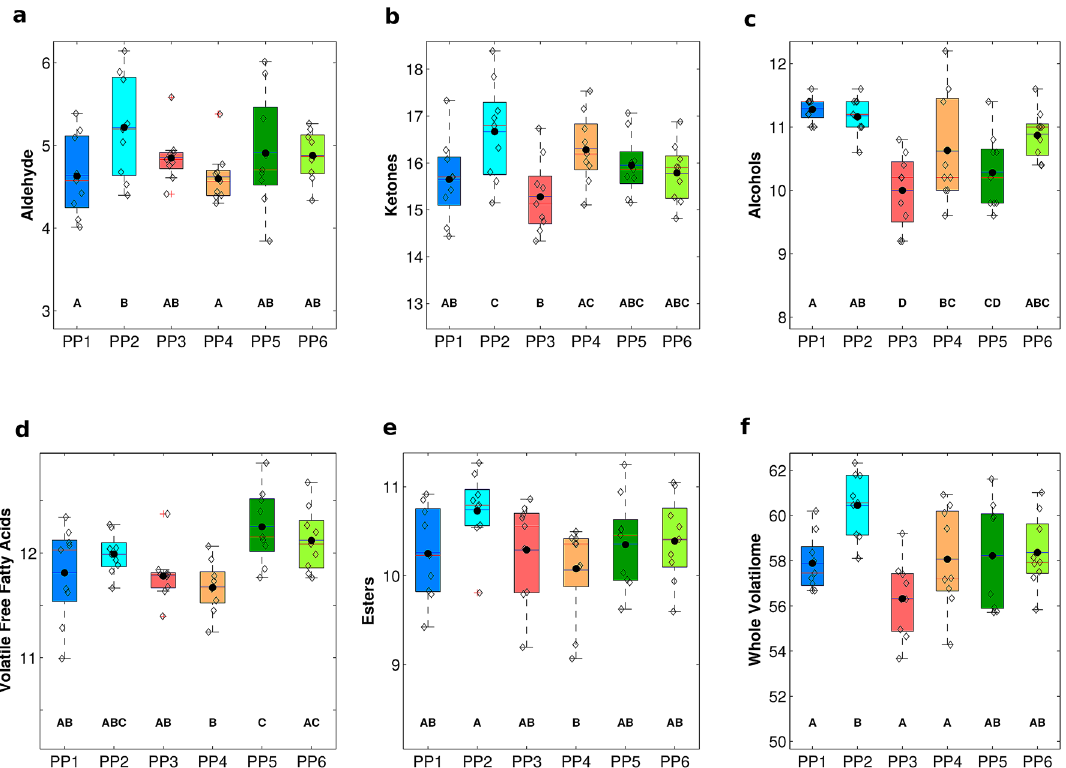
Figure 5. Box-plot of contents of the volatile compounds for each Pasture area-Producer: ( a ) aldehyde, ( b ) ketones, ( c ) alcohols, ( d ) volatile free fatty acids, ( e ) esters, ( f ) whole volatilome. Rhombus refer to HR cheese replicates. A mean value relative to cheese samples collected is indicated for comparison (dotted line). Data expressed as log 10 of the area of the Quant ion (LSM ± SEM). A–D Values between the boxplot of each compounds with different superscript letters differ significantly at P <